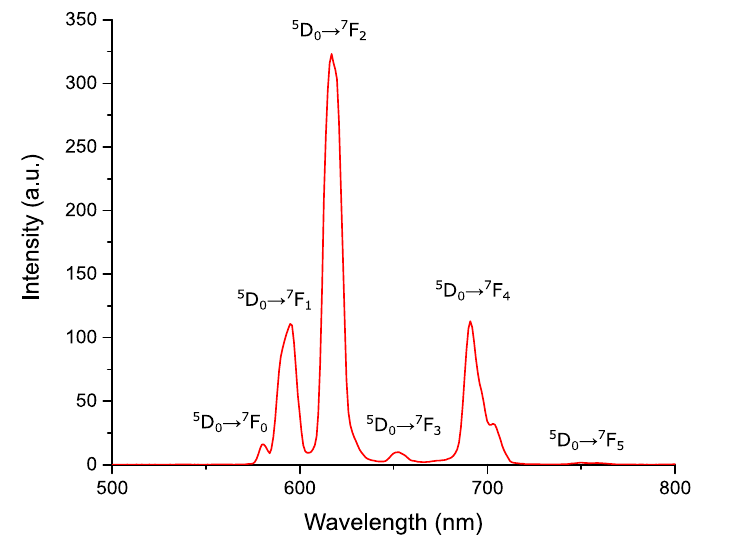
Figure 4. Europium cation luminescence spectrum of complex Eu • 4g in water at room temperature (excitation at 317 nm).